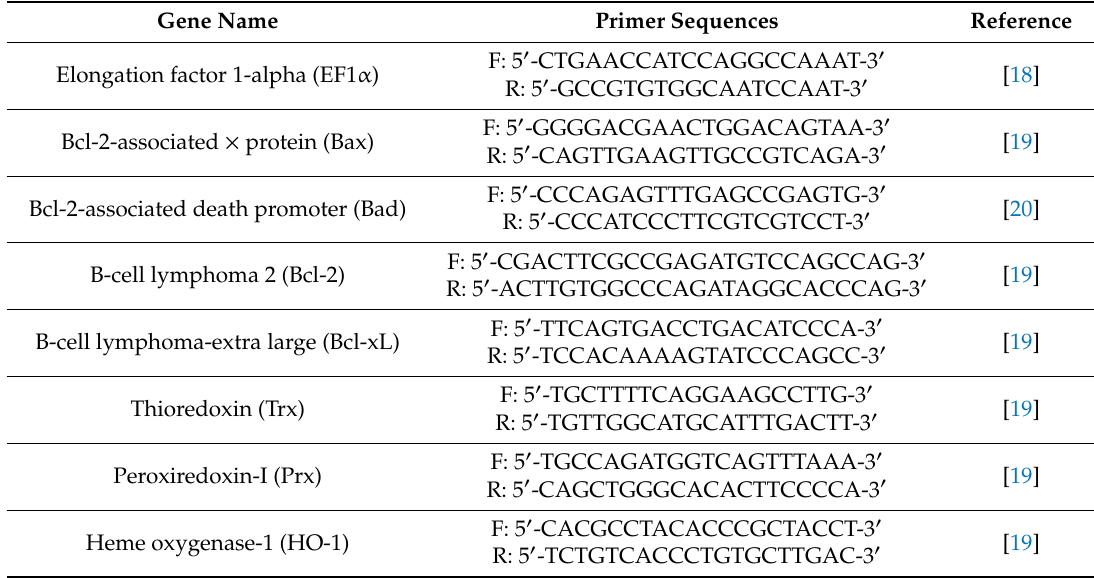
Table 1. Forward and reverse primer sequences used in real-time Reverse Transcriptase-Polymerase Chain Reaction